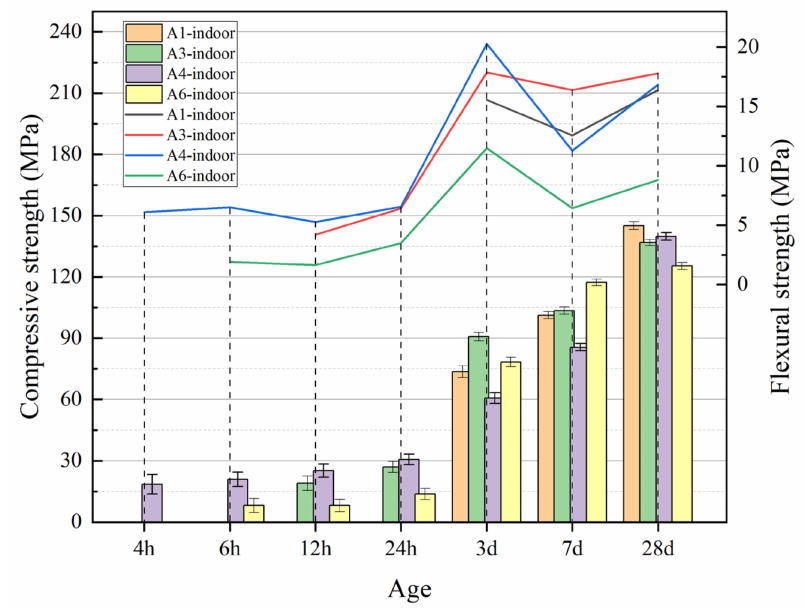
Figure 7. Mechanical performance of UHPC based on composite cementitious